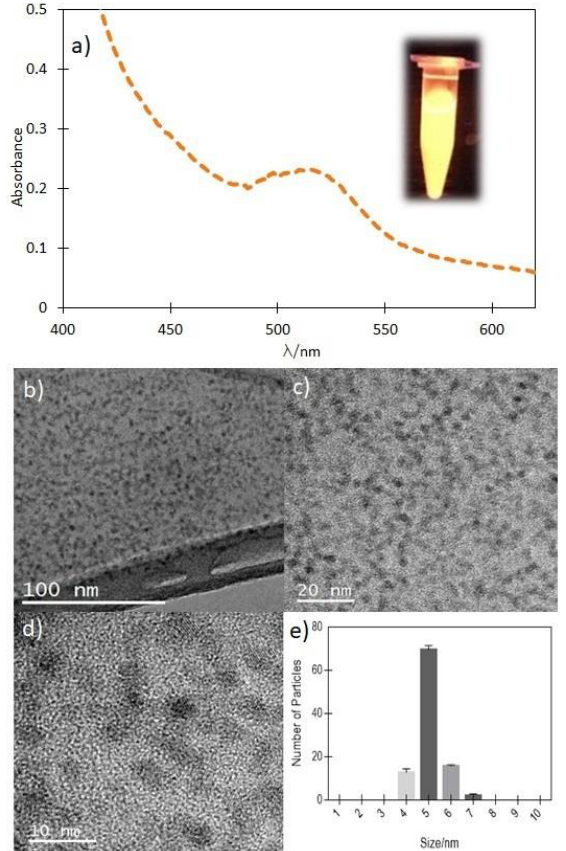
Figure 3. ( a ) UV-Vis absorbance spectrum of the GSH-CdTeQD synthesized in this work. The insert shows the sample fluorescence under UV light irradiation. ( b – d ) TEM analysis for a sample of GSH-CdTeQD at different magnification. The particle size distribution histogram is shown in ( e ).